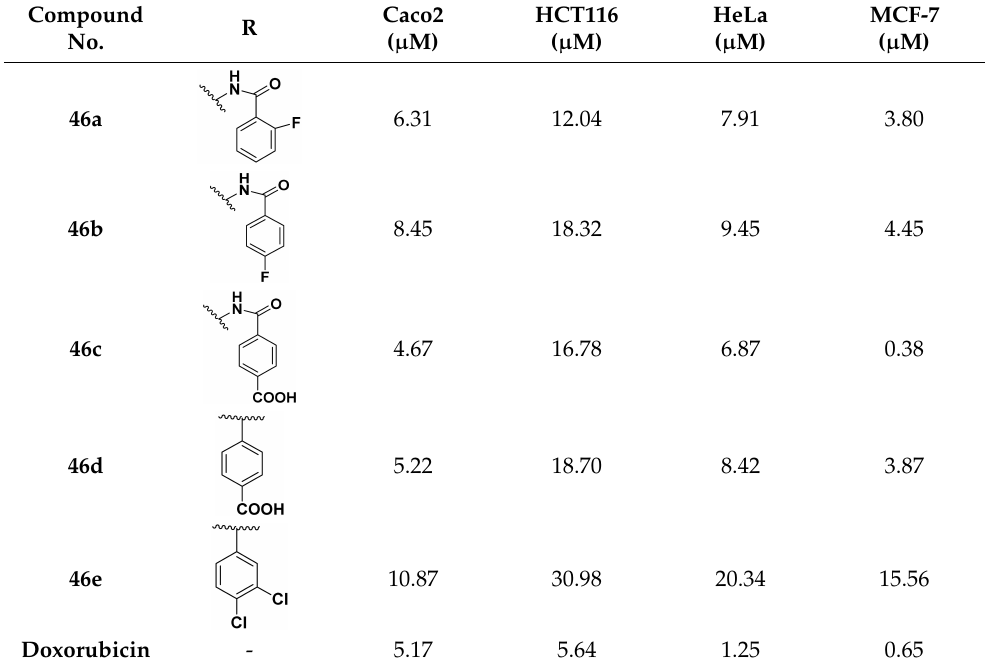
Table 39. In vitro cytotoxic activities of imidazole based triazole hybrid compounds 46 ( a – e ). Compound